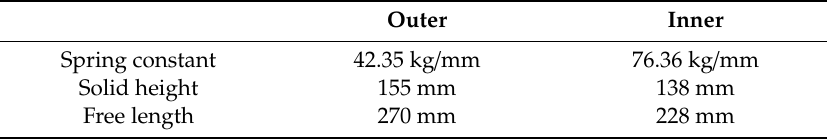
Table 8. The specification of bogie coil